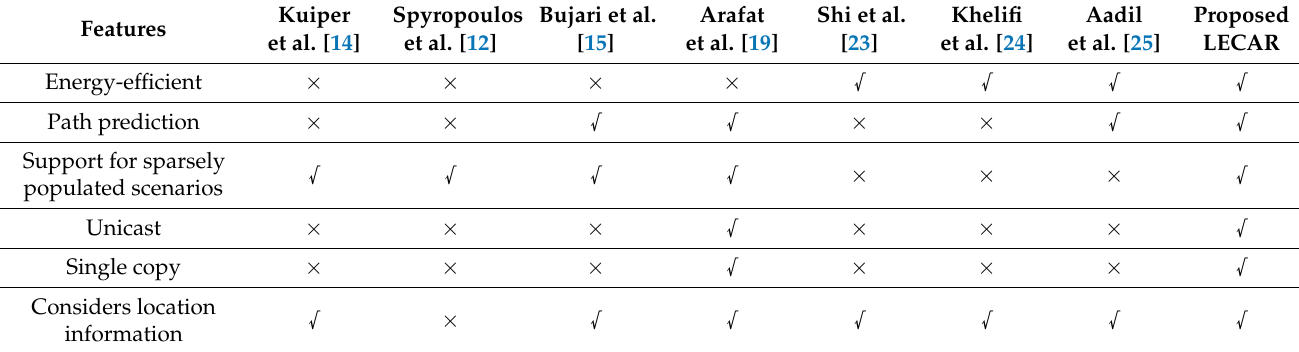
Table 1. Comparison of the features among the related major routing protocols for FANETs.